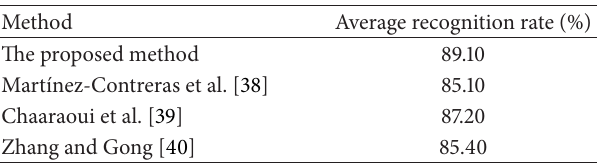
Table 6: Comparison with other approaches on the Weizmann action dataset.